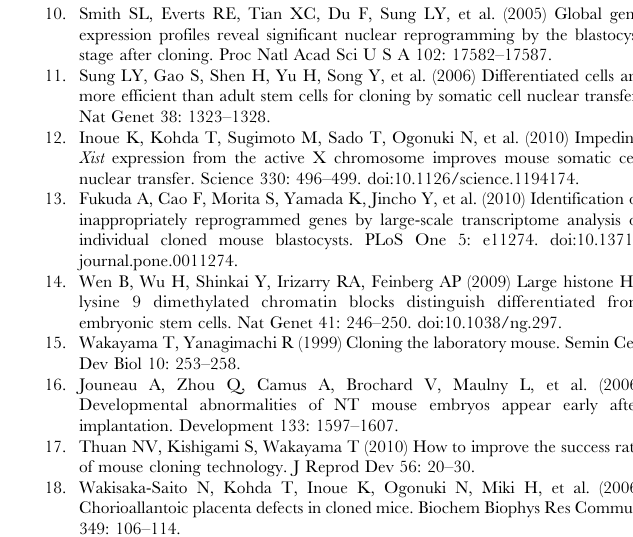
Figure S2: Expression of epiblast and extraembryonic markers of epiblast maker genes ( Nanog , Fgf5 and Nodal ) and extraembry- onic marker genes ( Krt7 , Phlda2 and Dnmt3L ) extracted from the microarray data. Nanog , Fgf5 and Nodal were detected significantly